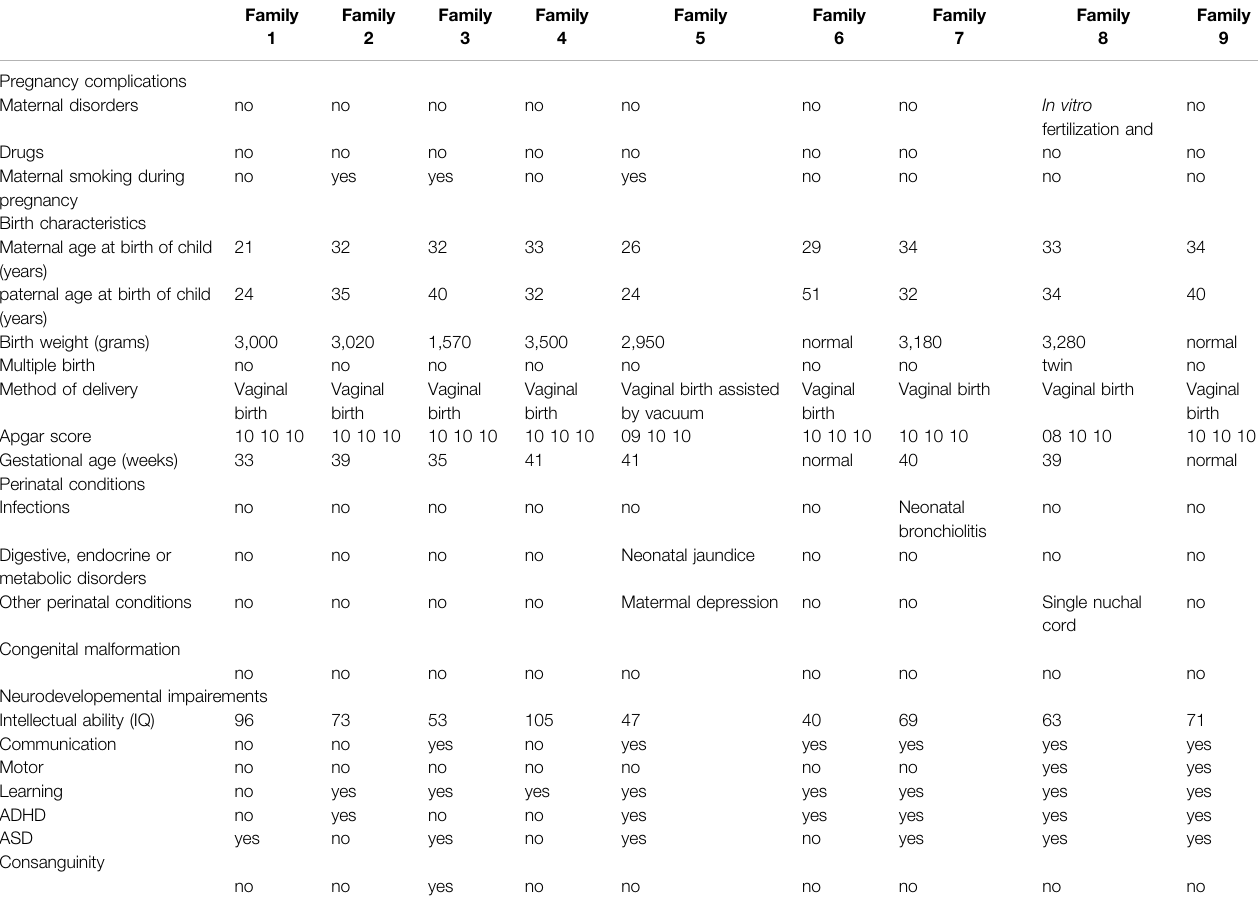
TABLE 1 | Prenatal, perinatal, and neurodevelopemental